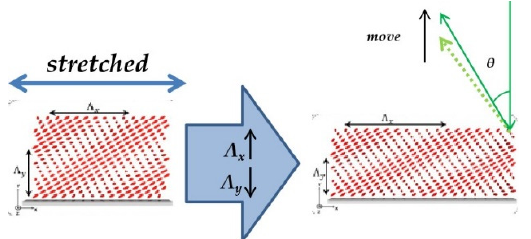
Figure 11. Schematic diagram of the designed PVGs for cyan (blue & green) ( a ) and red spectra ( b ) . ( c ) Simulated and experimental spectra for the two PVGs at normal incidence. [10] Reprinted with permission from [10] © The Optical Society. ( d ) Schematic drawing of the prototype. PVGs are used as the waveguide couplers.